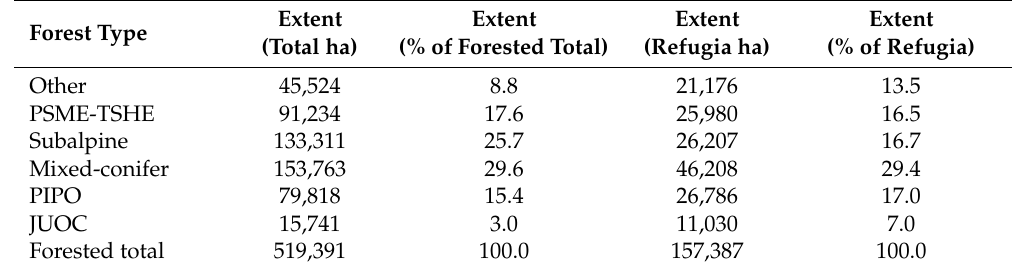
Table 3. Forest types across study fires according to GNN data